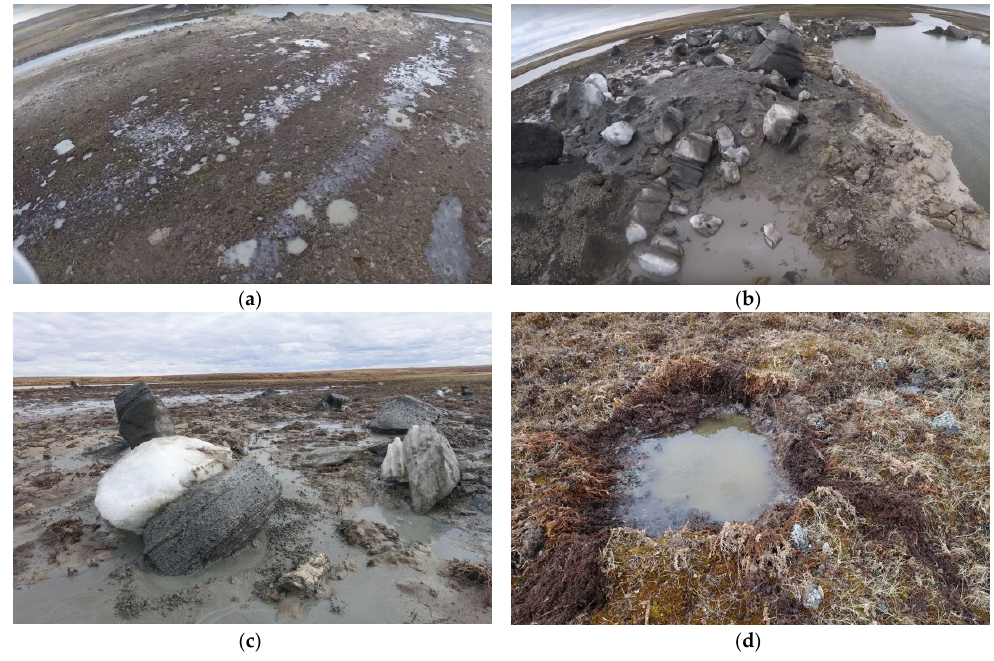
Figure 16. SeYkhGEC two days after formation: ( a , d ), impact hollows in the vicinity of SeYkhGEC; ( b , c ), ice blocks. Freeze frame from UAV video dated 02 July 2017, provided by A. V. Baryshnikov, “Russian Center for Arctic Development” are shown on ( a , b ); photograph by D. Ehrich, 02 July 2017 in ( c , d ).